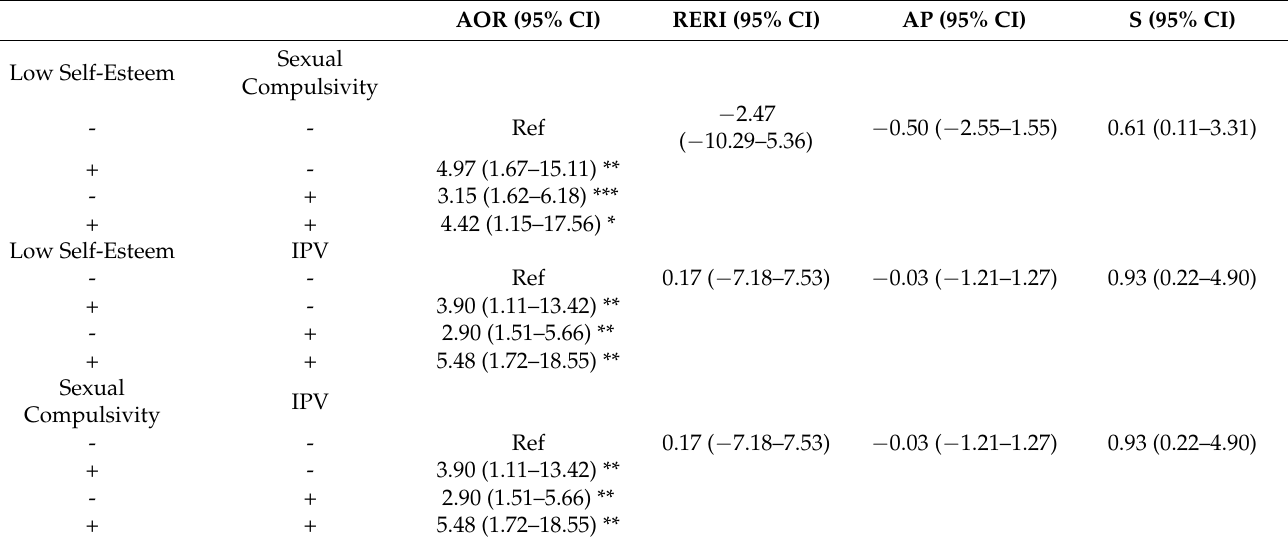
AOR: adjusted odds ratio, adjusted for education, monthly income, marital status, and HIV-testing outcome. * p < 0.05, ** p < 0.01, *** p < 0.001; -: absence of factor; +: presence of